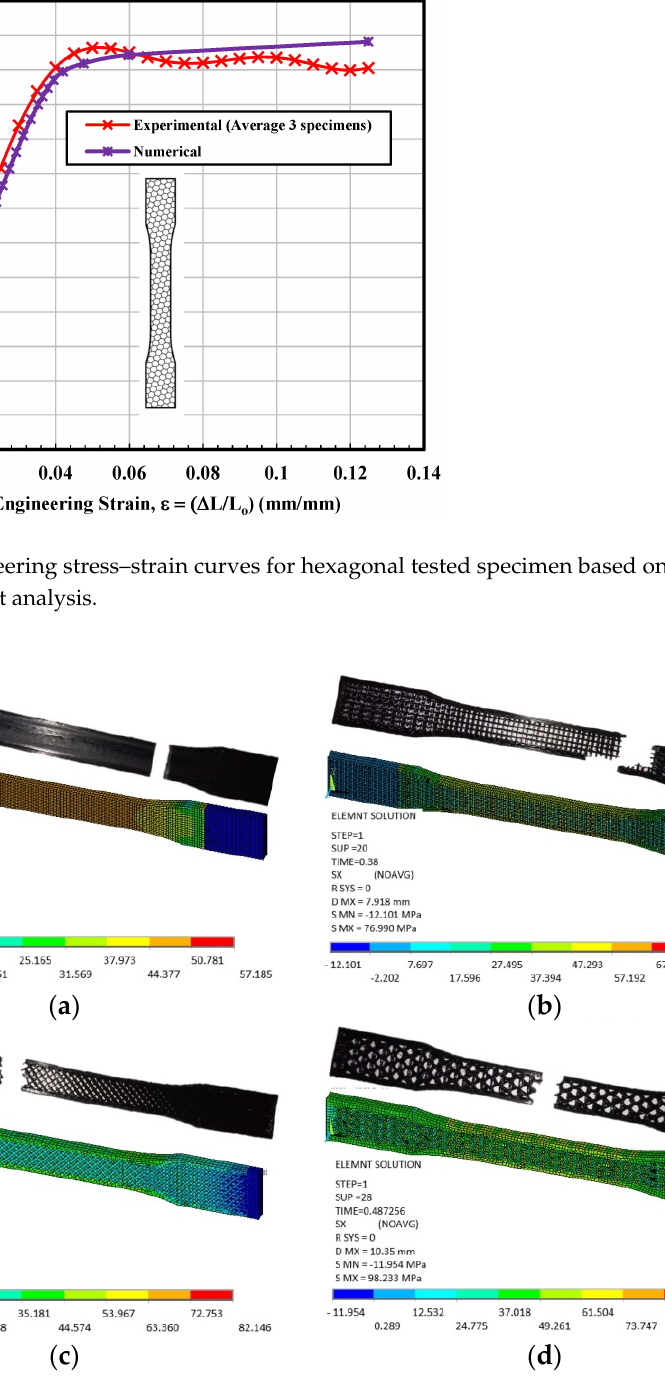
Figure 15. Stress distribution in the x ‐ direction for ( a ) solid, ( b ) rectangular, ( c ) diamond, and ( d ) hexagonal infill test specimen configurations based on finite element analysis.